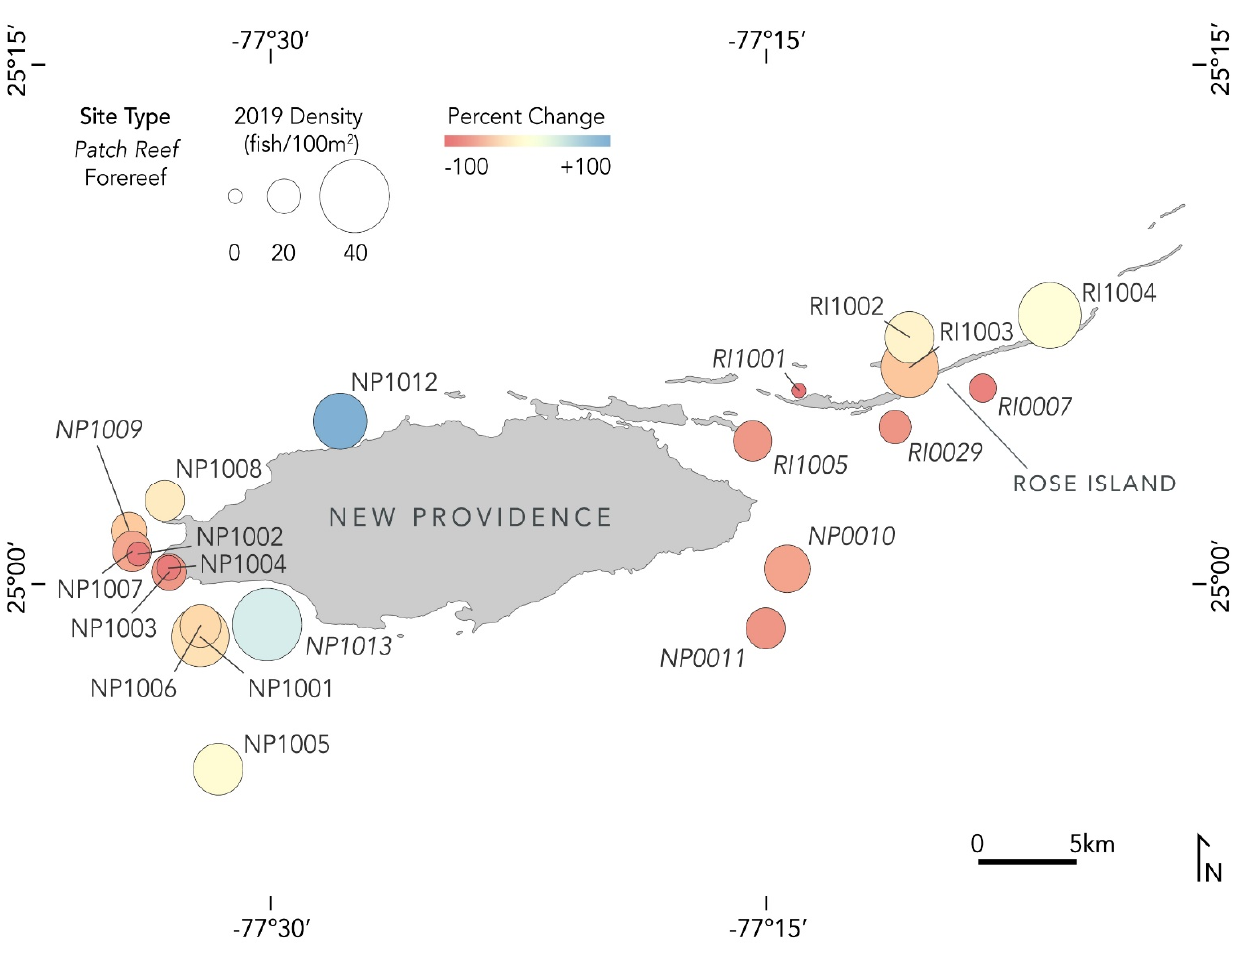
Figure 5. Percent changes in mean parrotfish densities (number of individuals per 100 m 2 ) across survey sites in New Providence. Circle sizes represent the mean density of parrotfish in 2019. The colors denote the percent change in parrotfish densities for the given site since the 2011–2012 survey period. Site codes for patch reefs are italicized and forereef sites appear in normal font.